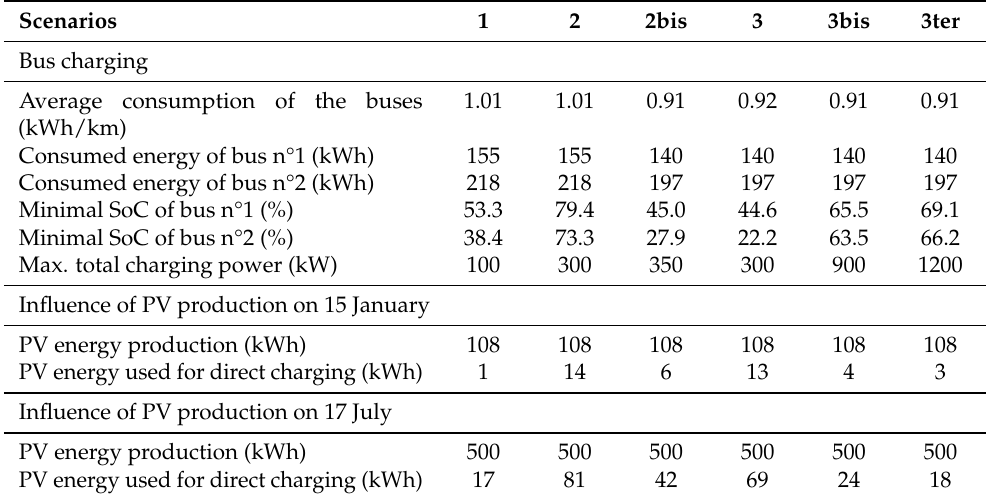
Table 5. Performance indicators per